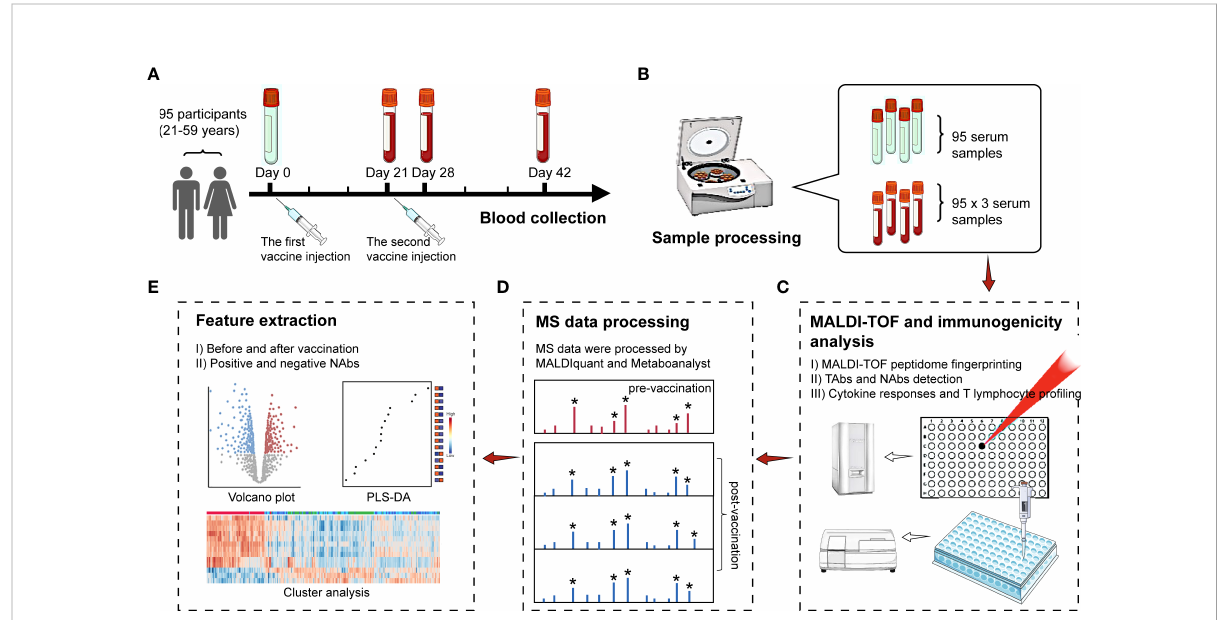
FIGURE 1 Study design. (A) Ninety- fi ve participantswererecruited and received two doses of CoronaVac vaccines. Blood samples werecollected at four time points before and aftervaccine injection. (B) Serum separation. (C) MALDI-TOF MSand immunogenicity analysis onallthe collected serum samples. (D) MALDI-TOF MSdata processing using MALDIquant and Metaboanalyst. (E) Featureselectionbased onvolcano plot and variableimportancein projection (VIP) scores by PLS-DA. Hierarchical cluster analyses (HCA) showed the intensity distributionof the selectedfeatures amongsamples. Peaks with an asterisk arepeaksof higher intensity fi ltered by the signal-to-noise ratioand areincludedin the analysis. Peakswithout an asterisk areby defaultnoise peaksand arenotincluded in the